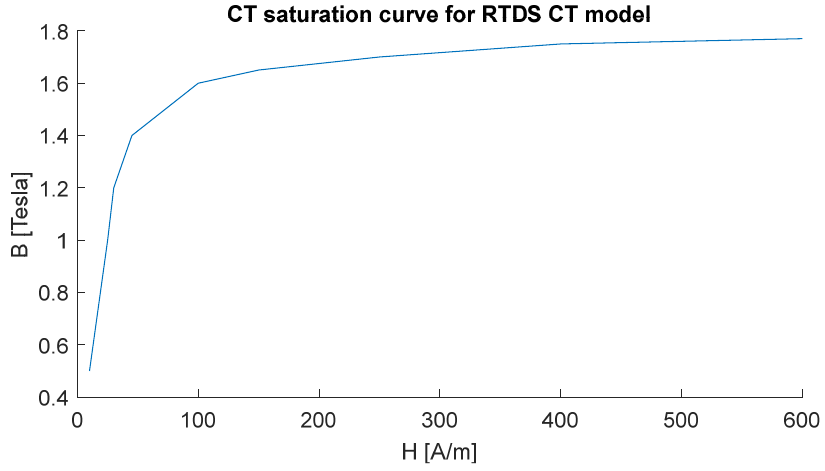
Figure 5. CT saturation curve for standard RTDS CT model.